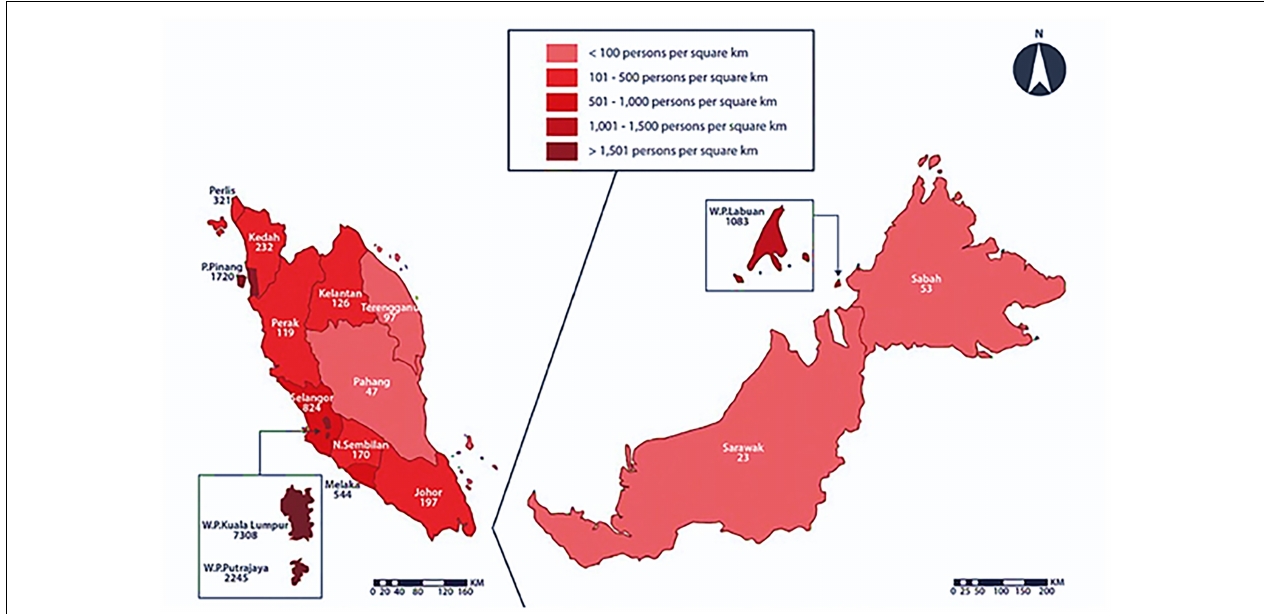
FIGURE 1 | Population density in each Malaysia state and federal territory. Sources: Population: Department of Statistics Malaysia (2020). In 2020, the Malaysian national average was 98.5 people/km 2 – the density of people in Malaysia has more than quadrupled since 1950 when there was an average of 18.6 people/km 2 . In 2020, the global average was 59.9 people/km 2 (United Nations,